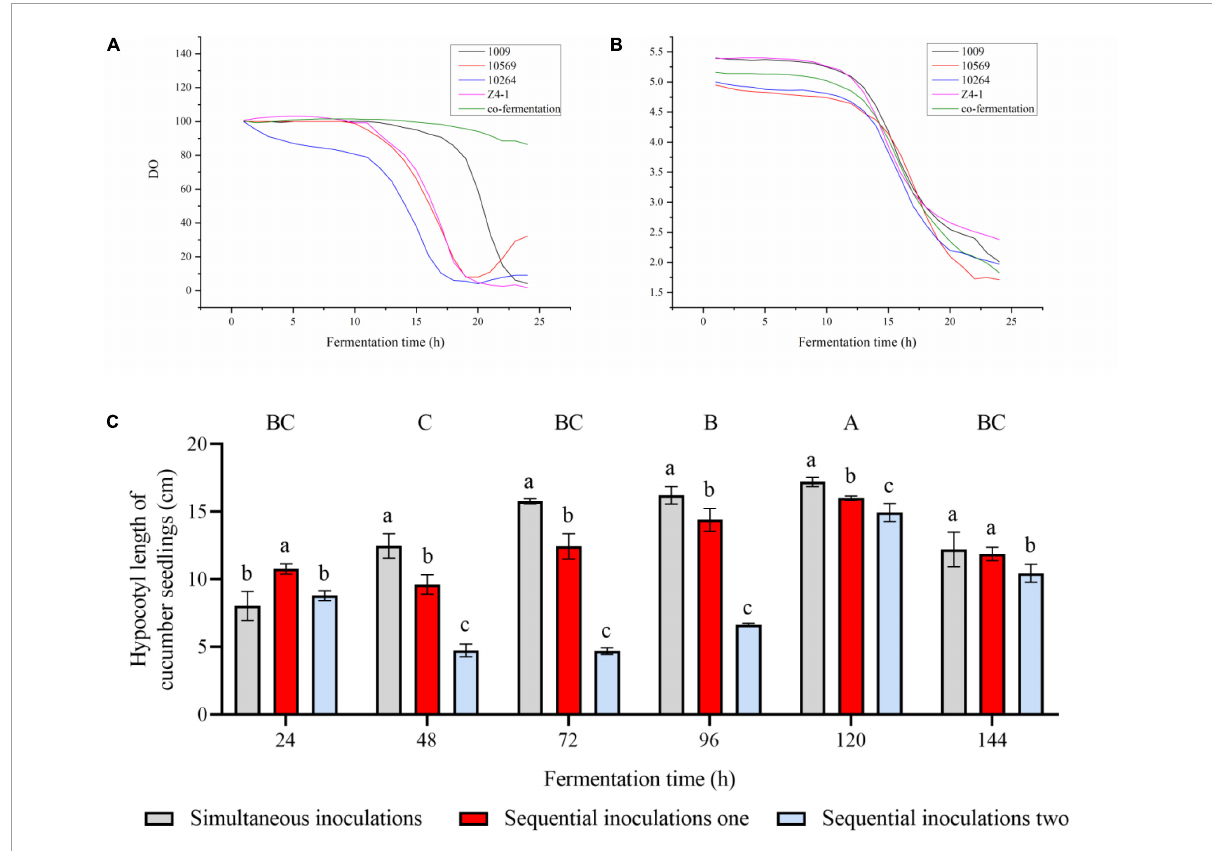
FIGURE1 Effect of inoculation technology on the bioreactor. (A) The dynamic curve of pH of Trichoderma co-fermentation broth in 50 L bioreactor. (B) The dynamic curve of dissolved oxygen (DO) in Trichoderma fermentation broth in 50 L bioreactor. (C) Effect of fermentation broth with different inoculation sequences on the growth of cucumber plantlets in vitro . Results are expressed as mean of five repeats, vertical bar represents standard error of the mean at significant ( P < 0.05) using Tukey’s HSD test. Different uppercase letters indicate the significant differences between time and lowercase letters indicates significant differences between treatments in different time intervals.